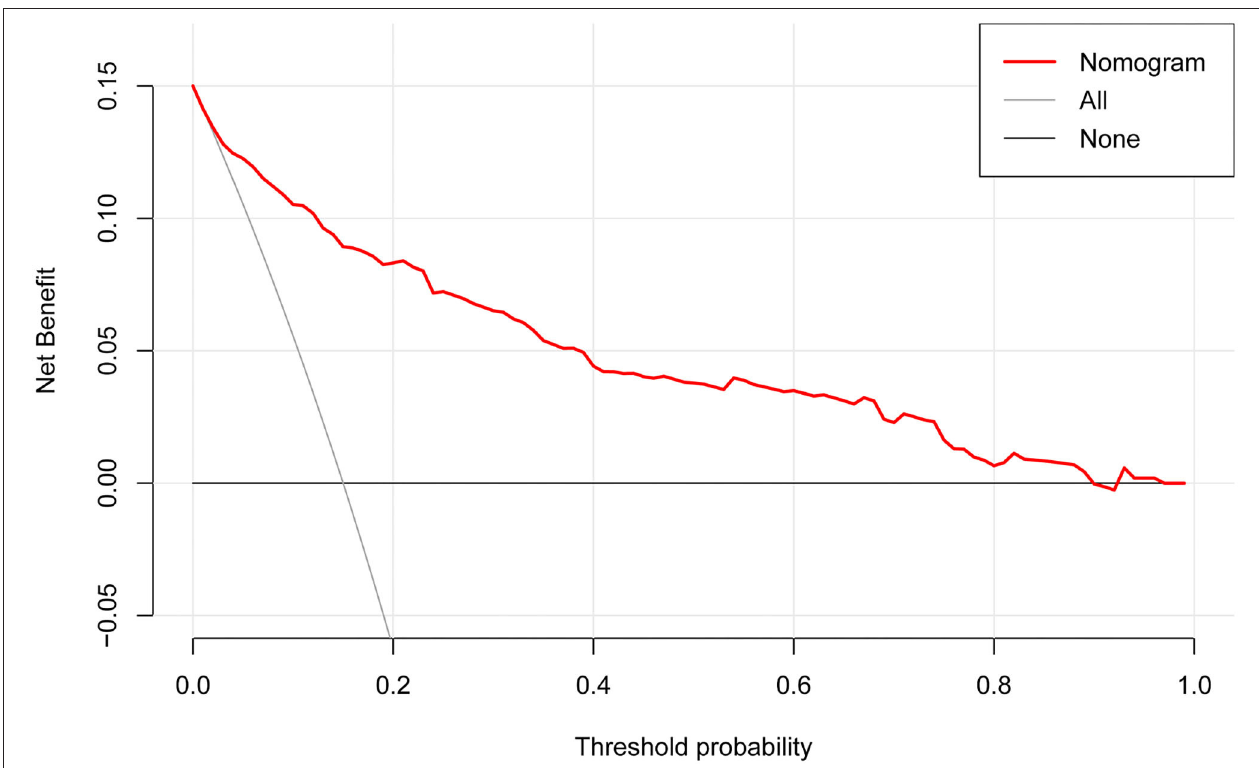
FIGURE 5 | Decision curve analysis for the nomogram. The X-axis showed the threshold probability. The Y-axis measured the net benefit. The red solid line represented the nomogram. The gray solid line represented the assumption that all subjects were possible rapid eye movement sleep behavior disorder (pRBD). The black solid line represents the assumption that no subjects were